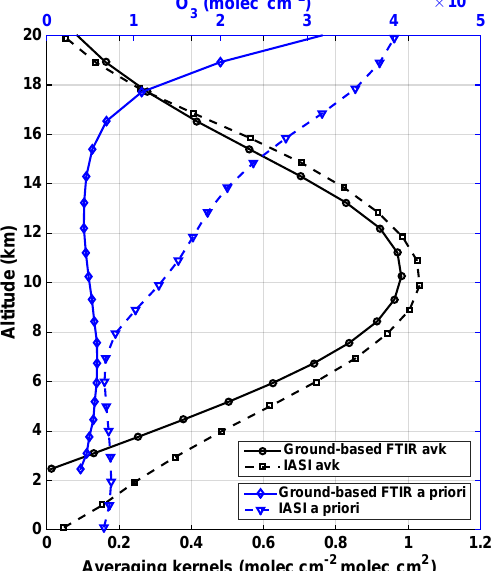
Figure 7. Lower x axis: ground-based NDACC FTIR (black curve and circles) and IASI (black dashed curve and squares) averaging kernels for the 8–16 and 6–16km partial columns, respectively. Up- per x axis: ground-based NDACC FTIR (blue curve and diamonds) and IASI (blue dashed curve and triangles) O 3 a priori